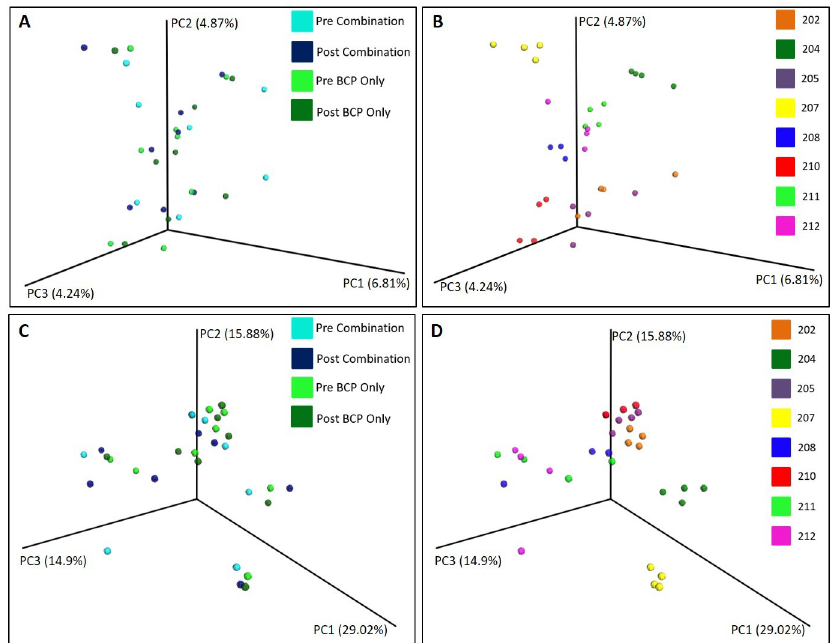
Fig 7. Changes in fecal microbial composition with treatment. UniFrac principal coordinate analysis (PCoA) plots of 16S sequencing data for (A) unweighted data by treatment group, (B) unweighted data by participant, (C) weighted data by treatment group and (D) weighted data by participant; numbers (e.g. 204, 212) represent participant